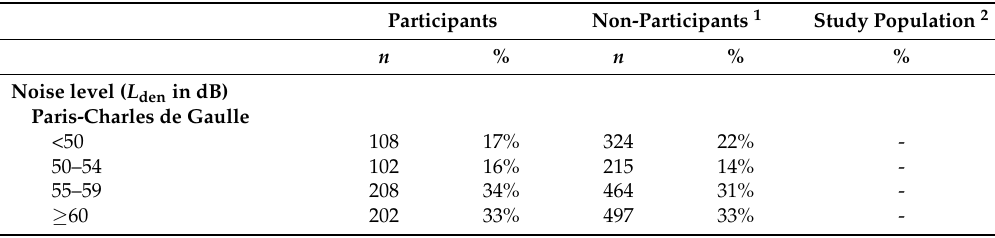
Table 1. Comparison of the demographic and socioeconomic characteristics of participants, non-participants, and the study